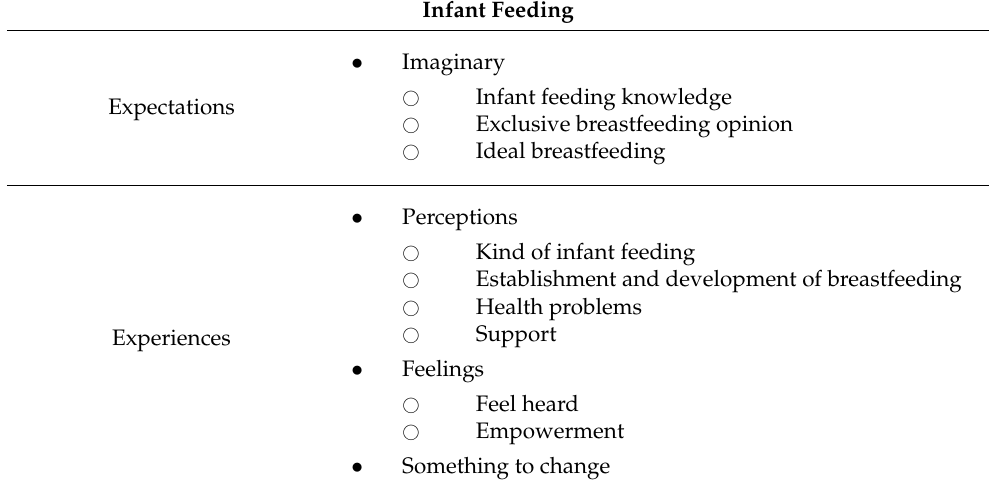
Table 1. Script for breastfeeding interview.